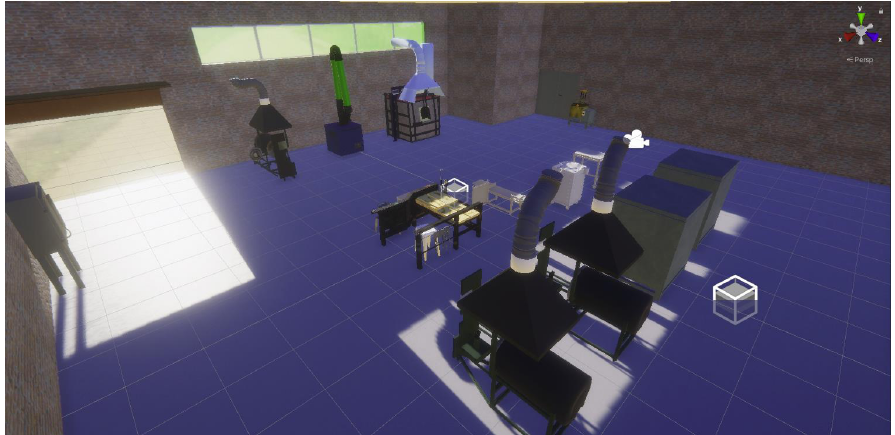
Figure 14. Placement of machinery following in the glass workshop.